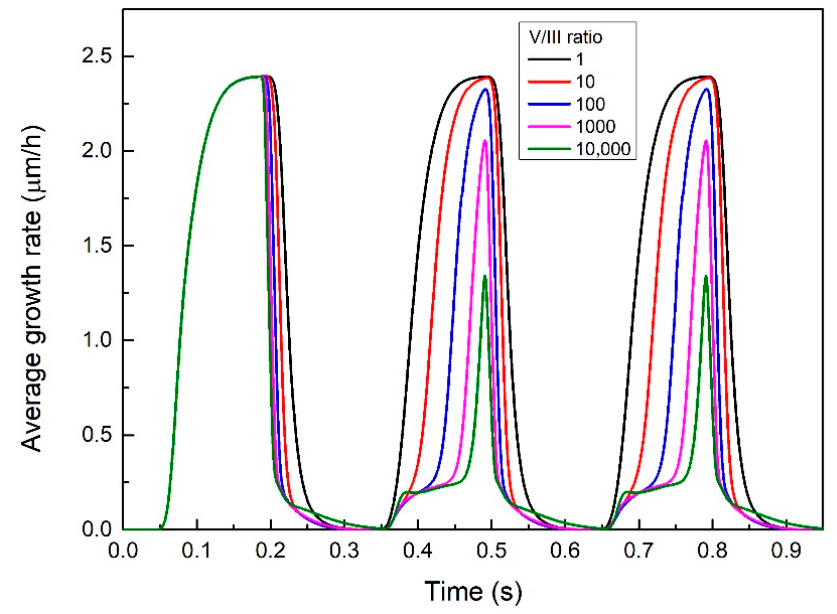
Figure 3. Average growth rate along the wafer surface during the pulsed process.